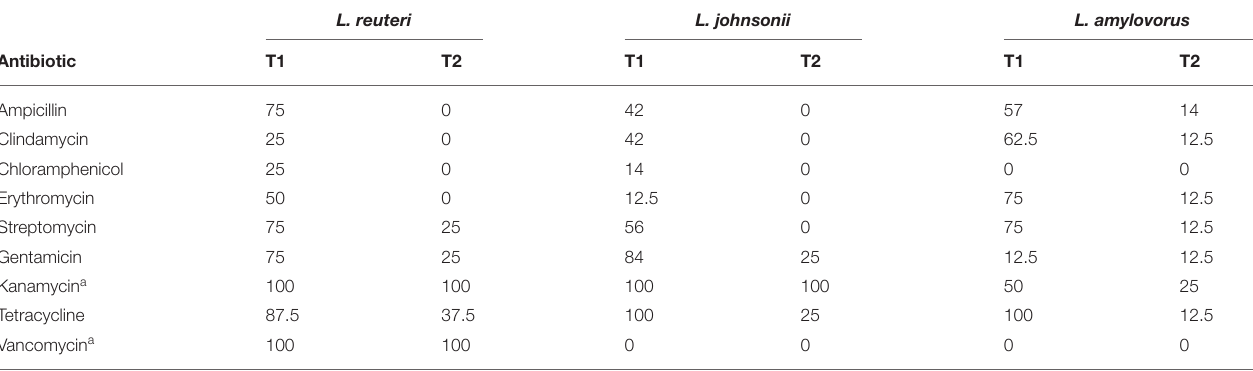
TABLE 4 | Antibiotic resistance rates (%) among the L. reuteri , L. johnsonii, and L. amylovorus strains isolated from the feces of 8-week-old piglets in the study farm before (T1) and after 2 years of antibiotic withdrawal and supplementation with L. salivarius MP100 (T2).